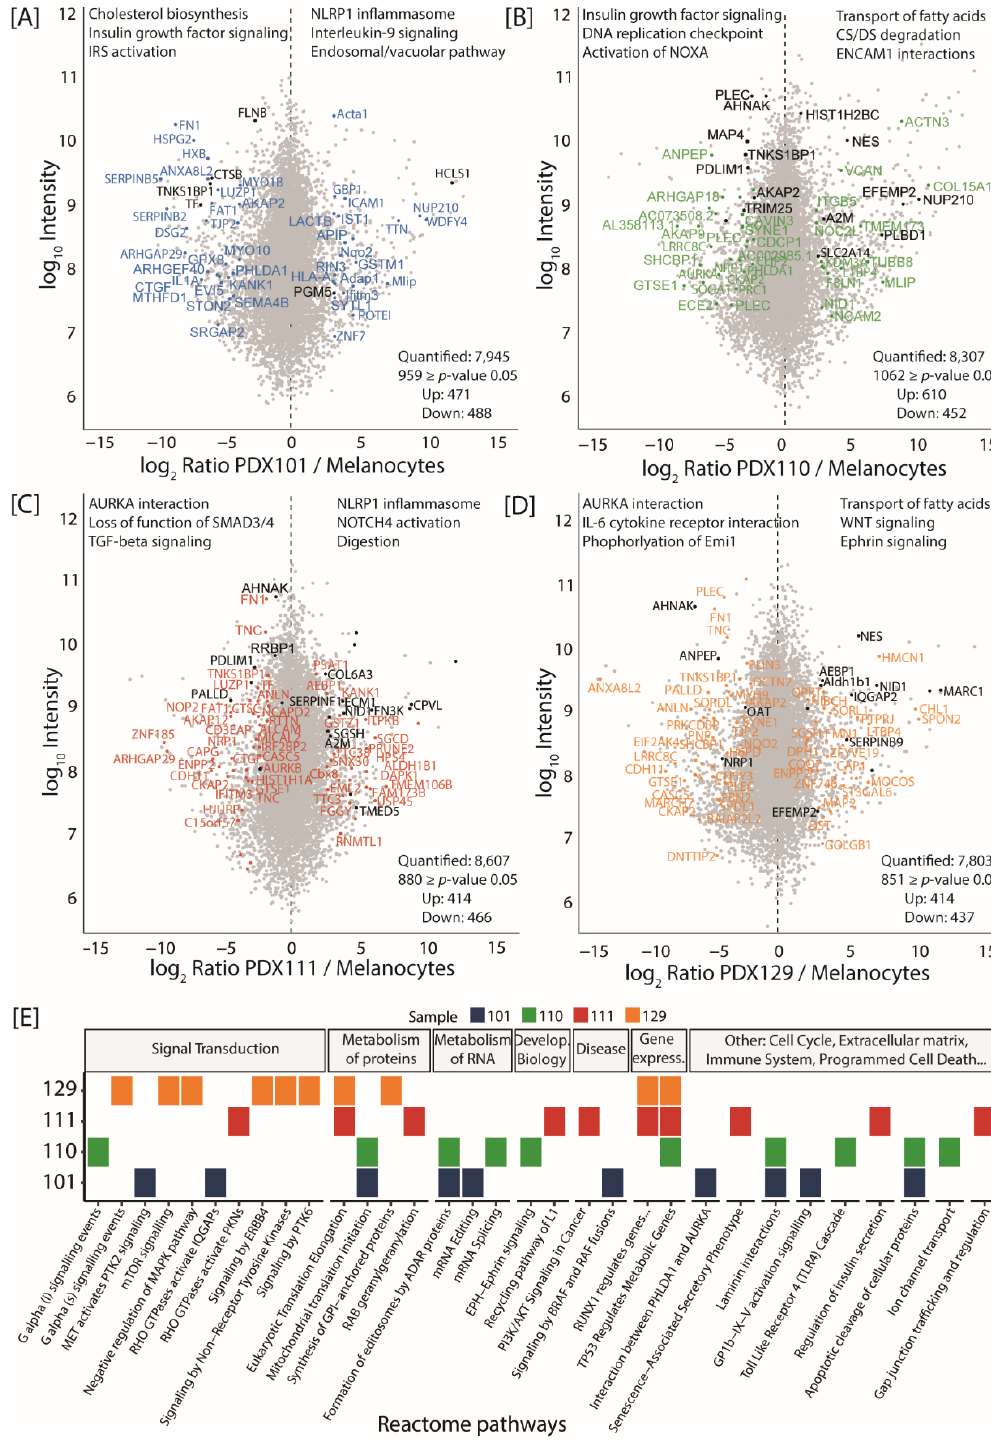
Figure 2. Comparison of tumor cells against melanocytes highlights patient-specific signaling pathways . ( A – D ) Scatter plot of log 2 -transformed ratios for proteins quantified in the PDX samples versus melanocytes for patient IDs 101 ( A ), 110 ( B ), 111 ( C ) and 129 ( D ). Significant proteins containing identified alternate peptides are marked in the respective color (significance B, p -value ≤ 0.05). Proteins marked in black were also identified in the corresponding FFPE material for each patient ID. The top 3 over-represented Reactome pathways based on all significantly up- or down regulated proteins are depicted in the upper part of each panel (Fisher-Exact test, p -value ≤ 0.2). ( E ) Heatmap of over-represented pathways within each patient based on proteins containing alternate variant peptides. Results are based on the Fisher-Exact test ( p -value ≤ 0.2). Color-coding indicates if a specific pathway was significantly over-represented in patient IDs 101 (blue), 110 (green), 111 (red) and 129 (orange).